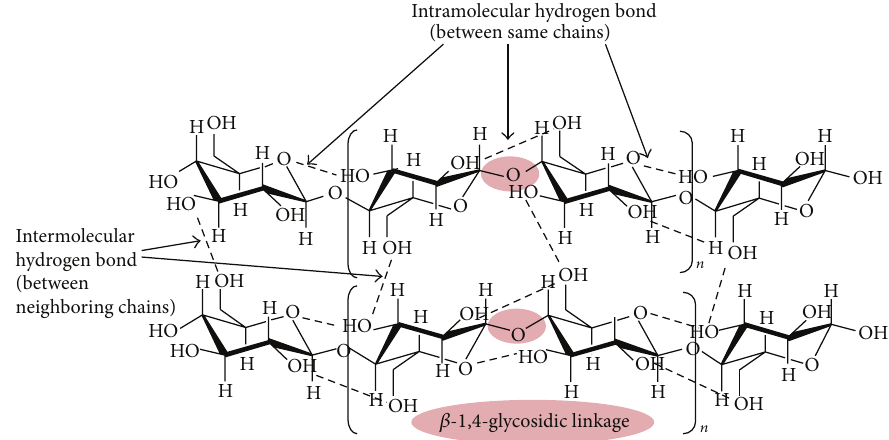
Figure 5: Chemical structures of cellulose chains.